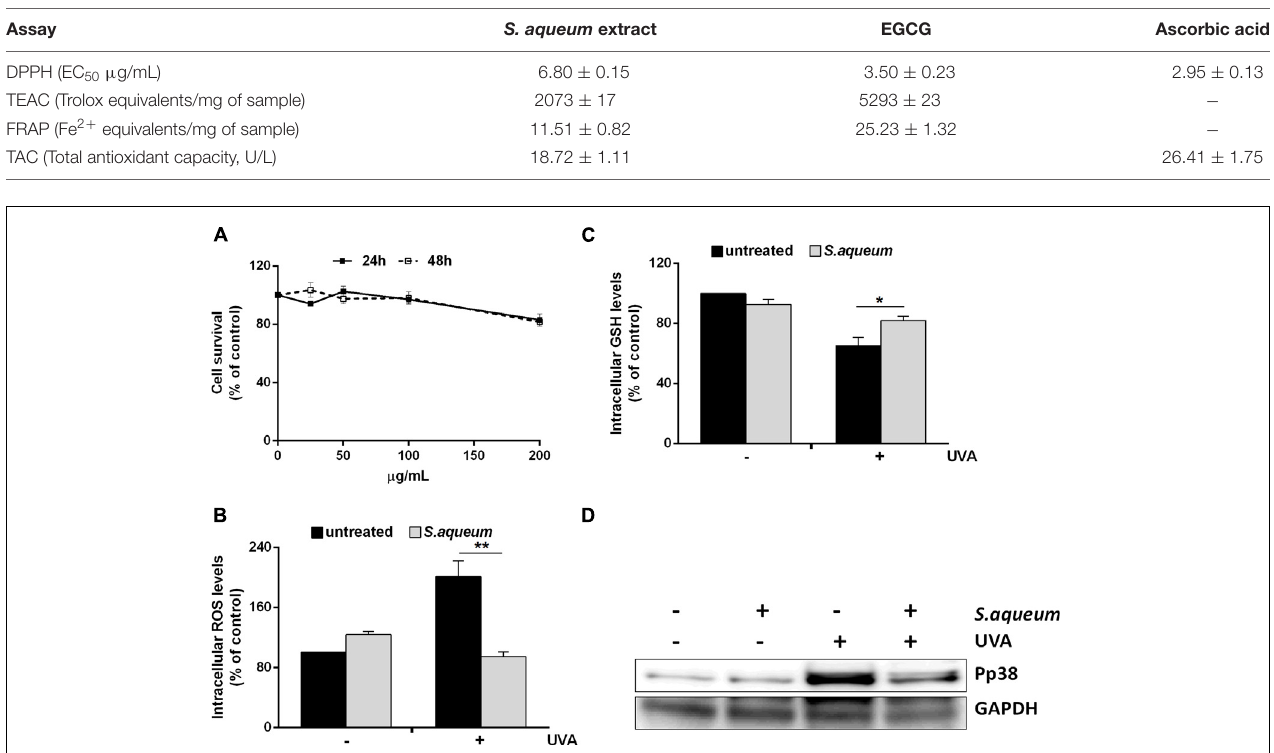
FIGURE 2 | Effect of Syzygium aqueum extracts on human keratinocytes. (A) Biocompatibility of S. aqueum extract in dose (25–200 µ g/mL) and time (24–48 h) manner. Survival rate of the cells was assessed by the MTT assay. (B) ROS production in cells treated or untreated with theextract (100 µ g/mL) and then irradiated by 100 J/cm 2 UVA (+) or not (–). (C) Total GSH levels determined by DTNB assay. Results expressed as mean ± SD of three assays. Significant ∗ p < 0.01; ∗∗ p < 0.001 compared to untreated control. Analysis performed by two-way ANOVA followed by Bonferroni’s multiple comparisons test. (D) Immunoblotting bands of the oxidative stress activated protein, p38. An equal amount (100 µ g) of total lysate from each sample was resolved by SDS-PAGE with GAPDH as a